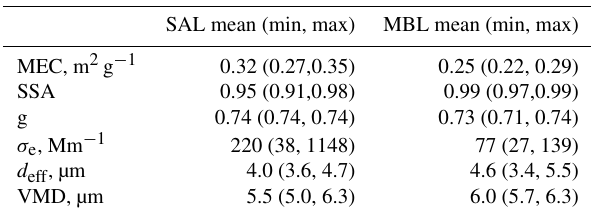
Table 6. Optical and size properties for the AER-D SAL and MBL campaign minimum, mean and maximum: optical properties of MEC, SSA, asymmetry parameter ( g ) and extinction coefficient ( σ e ) are given at 550nm. Effective diameter ( d eff ) and VMD are calculated directly from the 2-DS XY PSD; optical properties are calculated using the same PSDs and iterated RIs for each